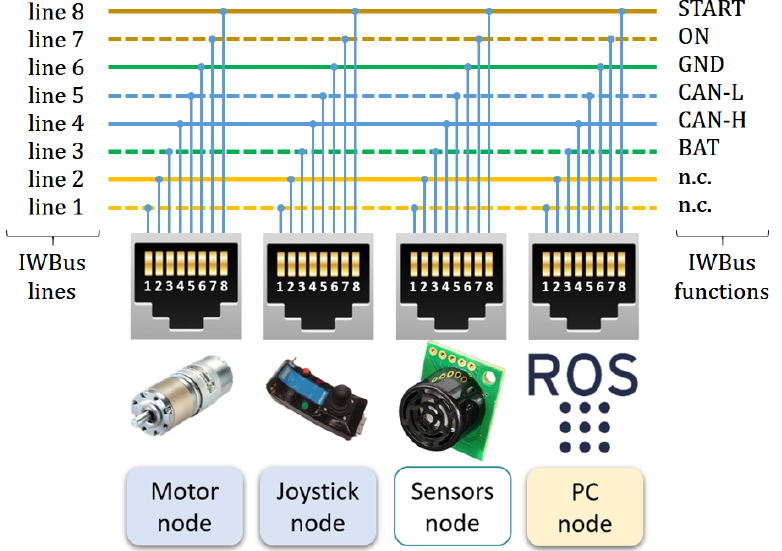
Figure 5. Detail of the CAN bus lines used to interconnect the